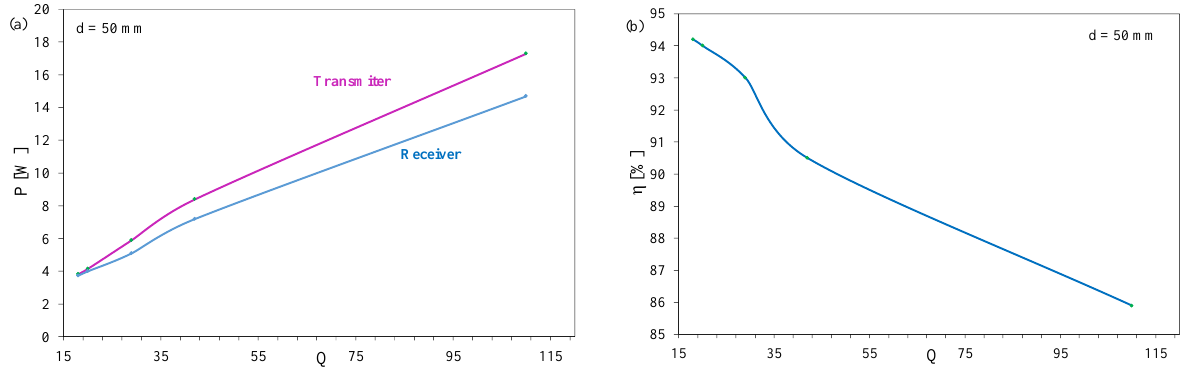
Figure 8. Dependence of the transmitted power between the transmitting and receiving coils ( a ) and the efficiency of energy transmission ( b ) on the quality factor of the coils.